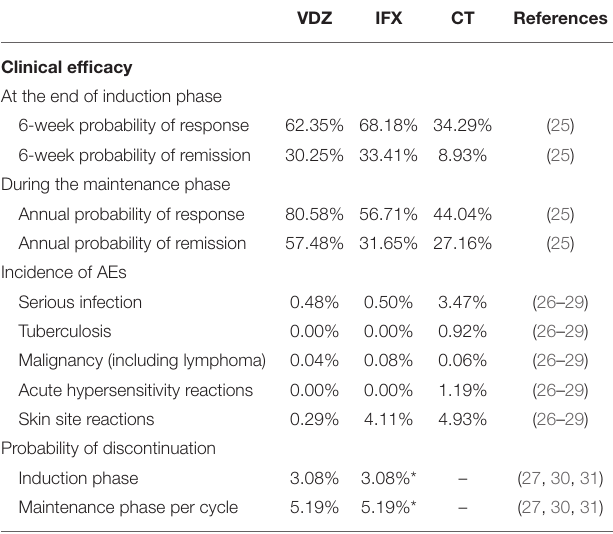
TABLE 1 | Model inputs for clinical efficacy, adverse events, and